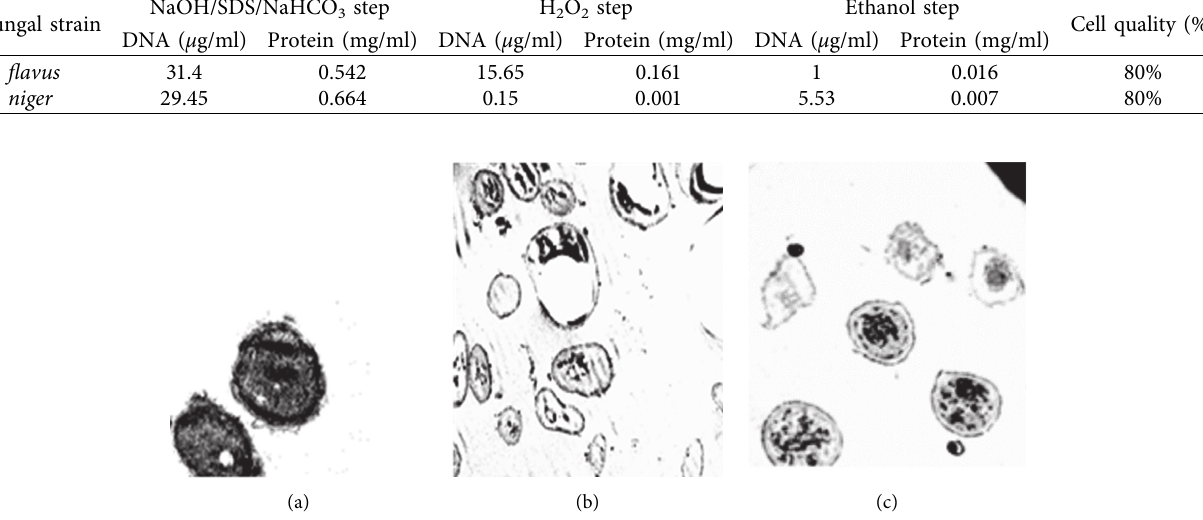
Table 2: Spectrophotometry evaluation of released DNA and protein from ghost cells and percentage of ghost cell quality. Fungal strain